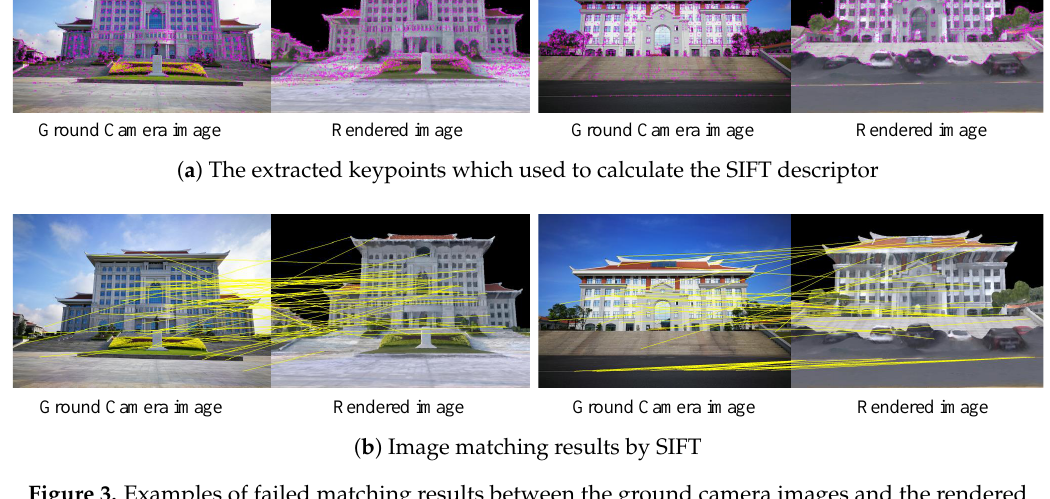
Figure 3. Examples of failed matching results between the ground camera images and the rendered images by SIFT. Left: Ground camera images; Right: Corresponding rendered images with the same